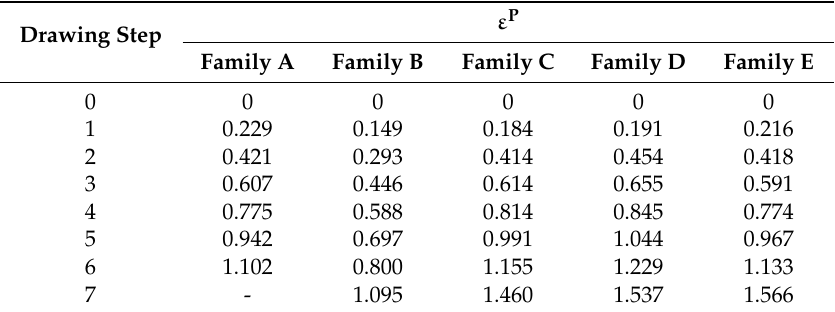
Table 3. Cumulative plastic strain of the progressively drawn